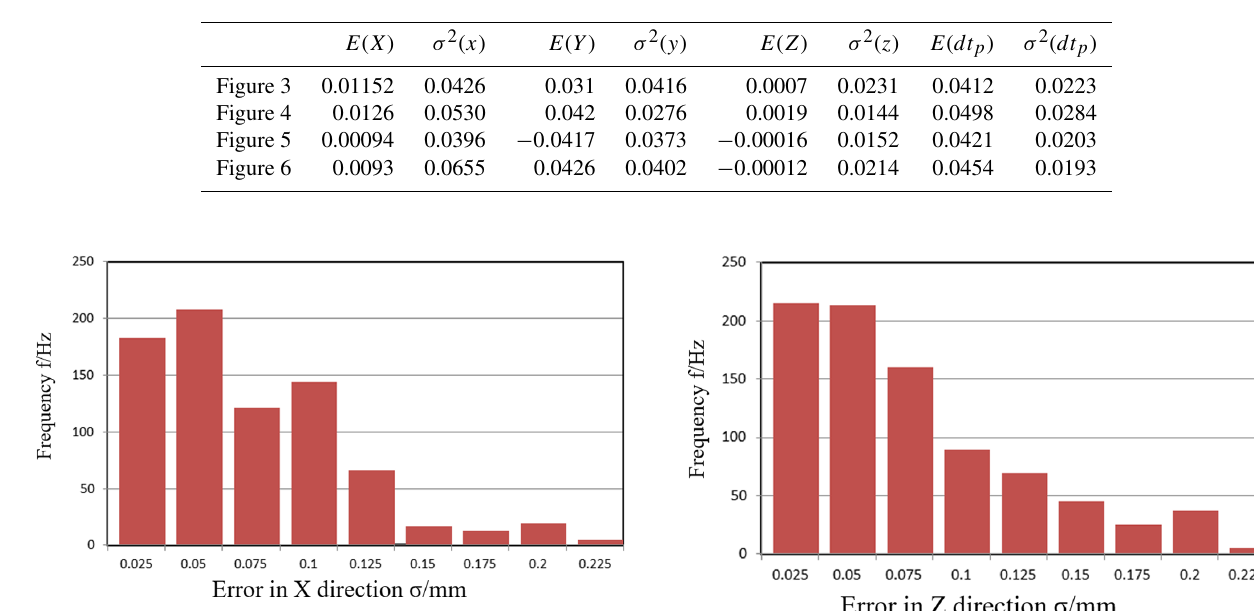
Figure 5. Frequency histogram of position error on working point in (0, 100, 1000) by matrix method.